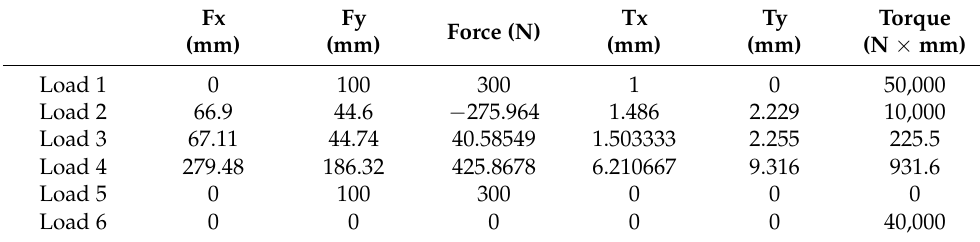
Table 1. Load Information